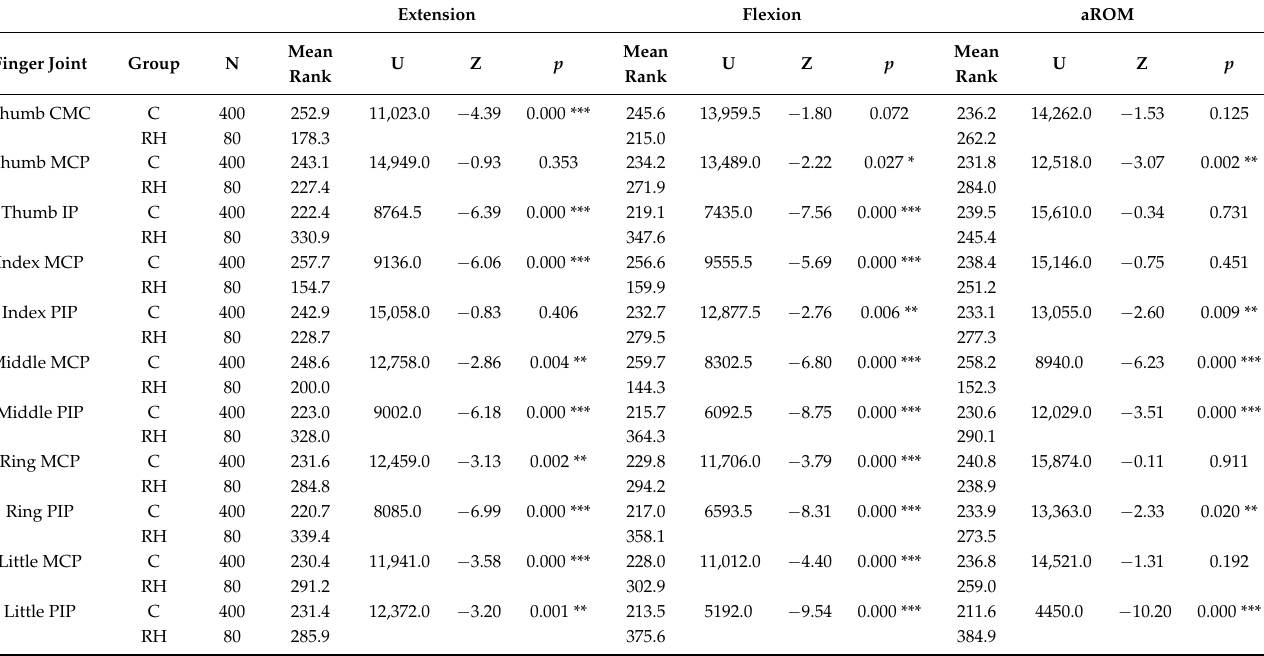
Table 5. Results of Mann–Whitney test of the ROM with respect to the control and right hemiparesis